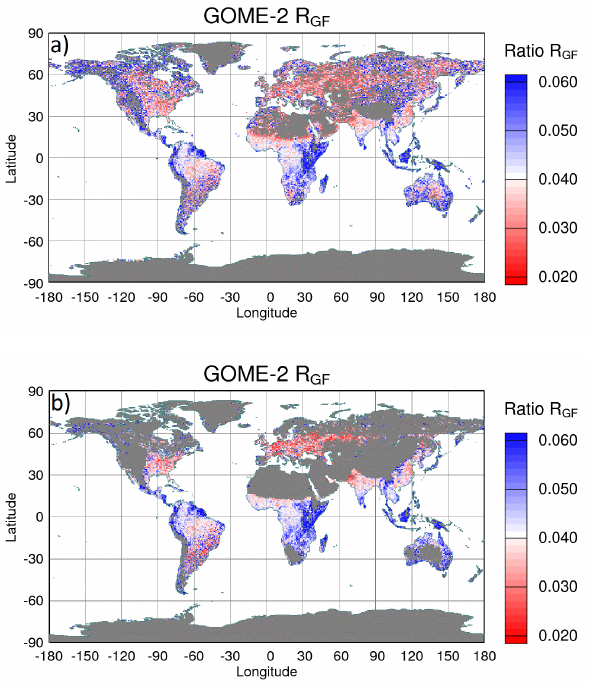
Fig. 3. (a) Global distribution over land of R GF , the ratio be- tween glyoxal and formaldehyde vertical column averages of the Figure 3: a ) Global distribution over land of R GF, the ratio between glyoxal and formaldehyde two years. Blue colour depicts increases in R GF values over 0.4 and vertical column averages of the two years. Blue colour depicts increases in R GF values over 0.4 and red values below this threshold. Grey regions indicate the absence of valid data due to large red higher decreased below this threshold. Grey regions correspond zenith angles, high surface reflectivity etc. Regions with dense population (e.g. China, Europe, and to an absence of valid data due to large zenith angles, high surface India) have lower R GF values while regions with dense vegetation are characterized by higher R GF reflectivity etc. Regions with dense population (e.g. China, Europe, values; b ) same as a) except for the exclusion of VCD CHO.CHO and VCD HCHO values close to or below and India) have lower R GF values while regions with dense vege- their detection limit of 2 . 10 14 molec cm -2 and 2.5 . 10 15 molec cm -2 respectively, prior to their tation are characterized by higher R GF values; (b) Same as before division. The highest, blue values, are found over Indonesia and northeastern South America except the filtering out of the VCD CHO . CHO and VCD HCHO val- while the lowest, red ones, depict regions influenced by anthropogenic emissions. ues close or below their detection limit of 2 × 10 14 moleccm − 2 and 2.5 × 10 15 moleccm − 2 respectively, prior their division. The high- est, blue values, are found over Indonesia and northeastern South America while the lowest, red ones, depict regions influenced by anthropogenic